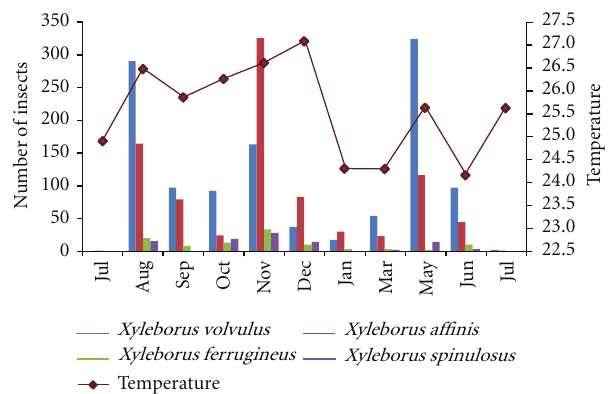
Figure 4: Monthly temperature and total number of four of the most abundant species of Scolytinae subfamily collected with pitfall traps from July 2005 to July 2006, in primary forest of Central Amazon.